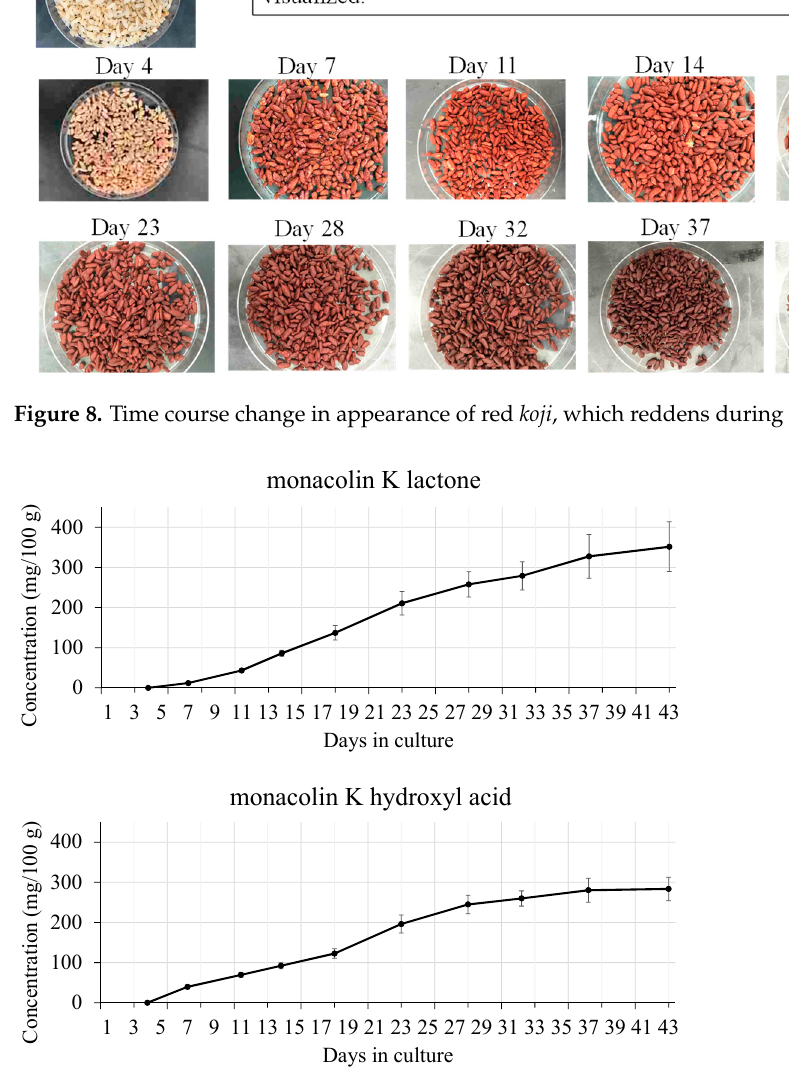
Figure 10. Time course change in the contents of 3 azaphilone pigments in red yeast rice during fermentation, quantified according to the reference method [30].